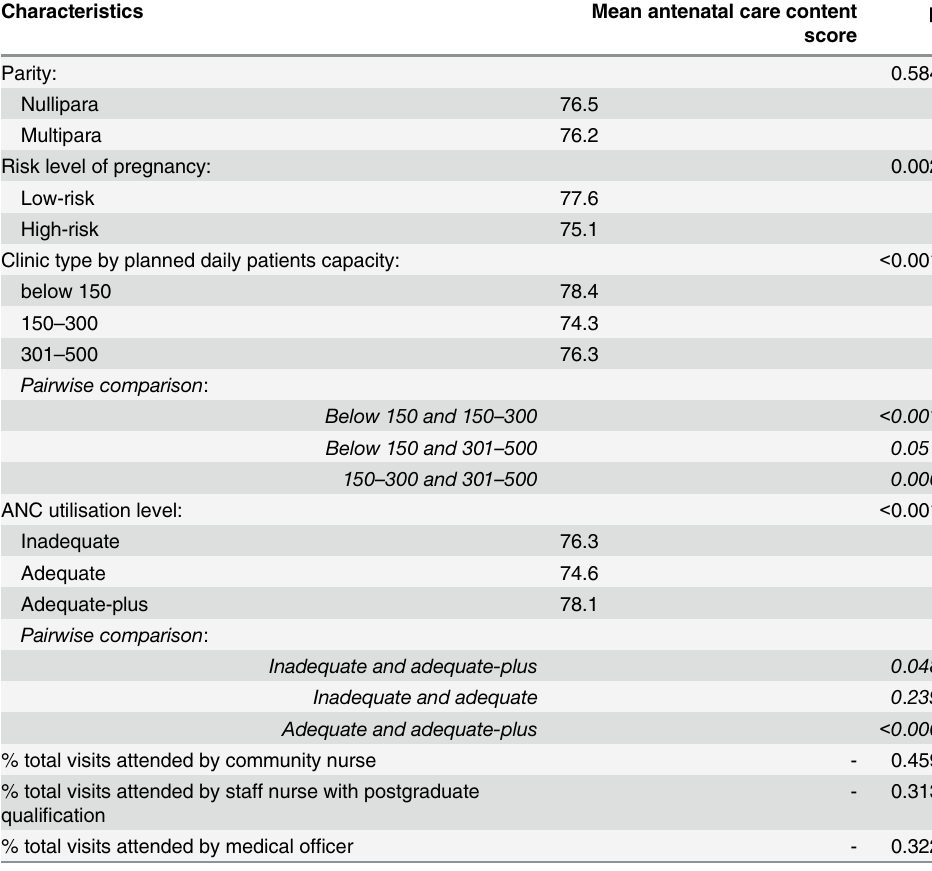
Table 3. Difference of mean for antenatal care content score in % by selected characteristics (n = 522).